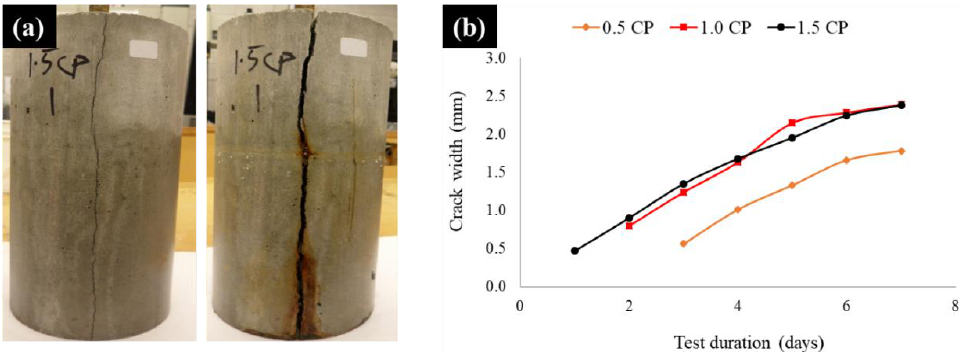
Figure 6. ( a ) Typical surface crack in 1.5 CP specimens after 1d and 7d; ( b ) crack